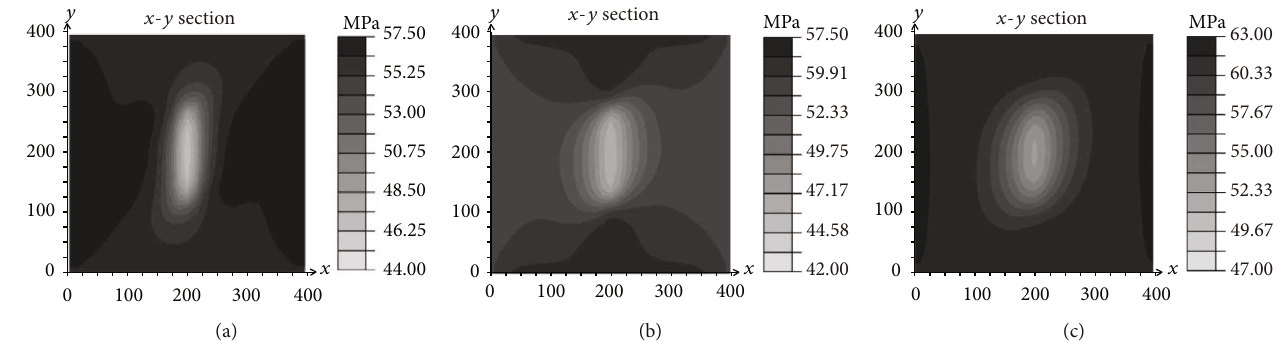
Figure 7: (a), (b), and (c) present the principal stress in the x -direction, y -direction, and z -direction considering the in fl uence of the permeability tensor of natural